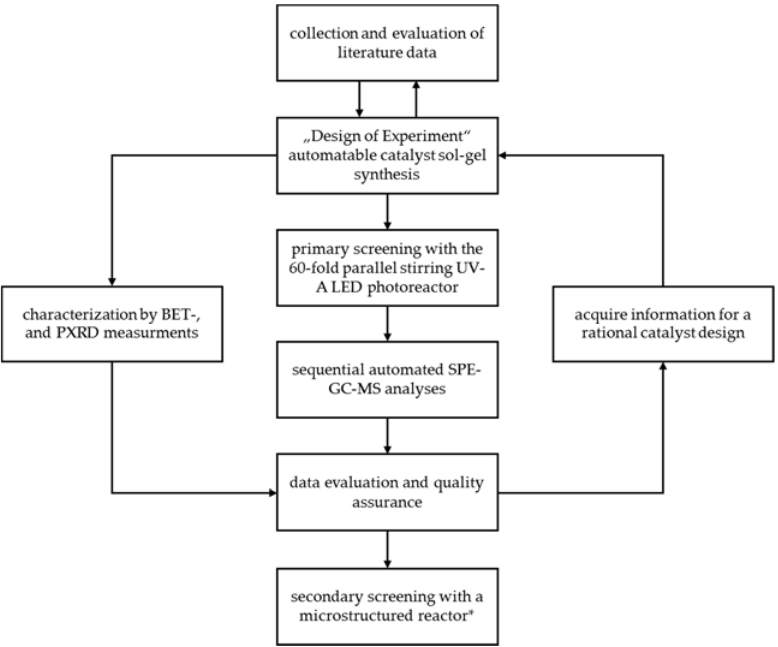
Figure 9. High throughput workflow for photocatalyst research utilising the 60 ‐ fold parallel stirring UV ‐ A LED photoreactor during primary screening; *in progress.